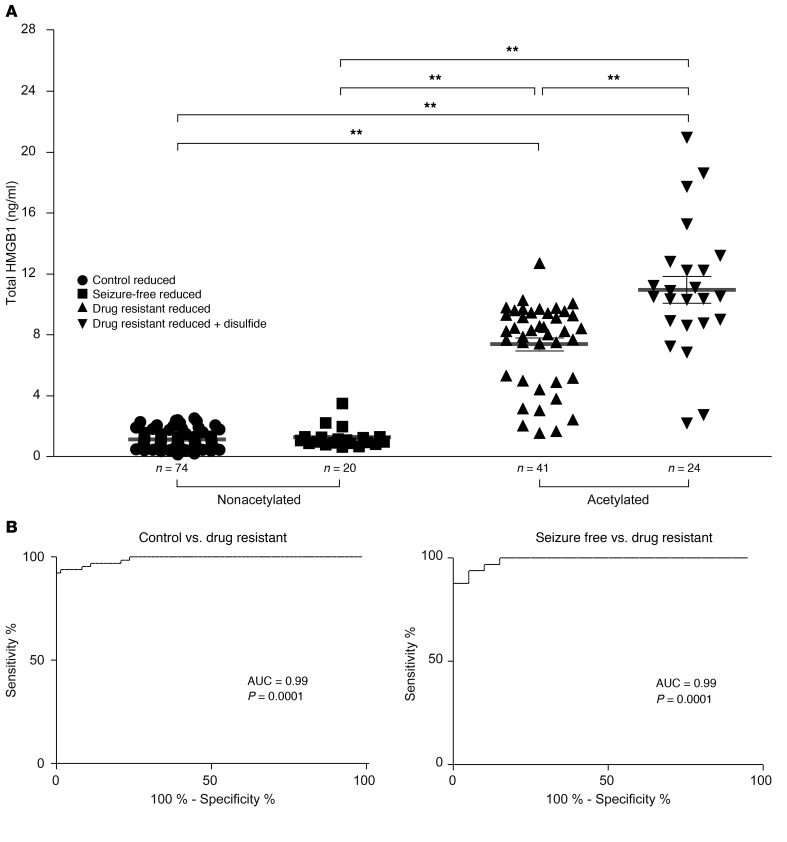
HMGB1 levels in blood of drug-resistant and drug-sensitive epilepsy patients and healthy controls.(A) Total HMGB1 levels in healthy controls (1.1 ± 0.07 ng/ml, n = 74) and patients with well-controlled epilepsy (1.2 ± 0.15 ng/ml, n = 20) or drug-resistant epilepsy (8.7 ± 0.47 ng/ml, n = 65; P < 0.01). Acetylated HMGB1 was detectable only in patients with drug-resistant epilepsy, and these individuals could be further stratified on the basis of the presence of disulfide HMGB1 (drug-resistant, reduced HMGB1 7.1 ± 0.4 ng/ml, n = 41; reduced+disulfide, 11.0 ± 0.9 ng/ml, n = 24; P < 0.01). Data are presented in each group as individual values as well as the mean ± SEM. **P < 0.01, 1-way ANOVA. (B) ROC analysis shows that total HMGB1 discriminates (AUC = 0.99) between patients with drug-resistant seizures and both healthy controls and those with well-controlled seizures.